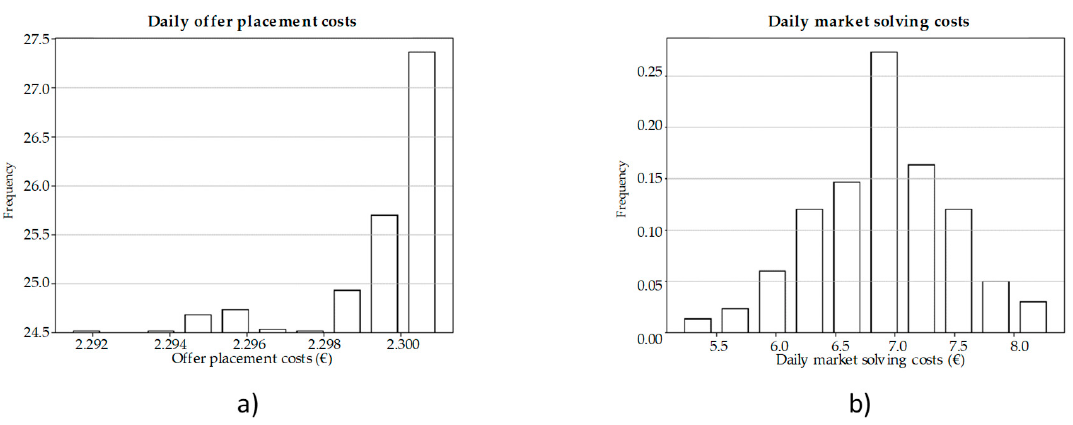
Figure 8. The histograms of estimated daily costs for: ( a ) offer placement by means of the market operators in the case study; ( b ) daily market solving cost over 24 market sessions, paid by the SO.